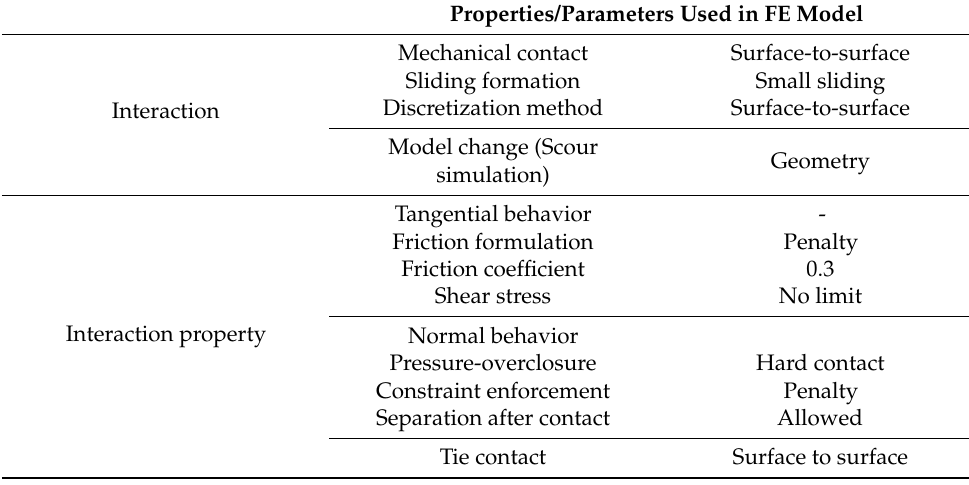
Table 2. Interaction properties used in the FE